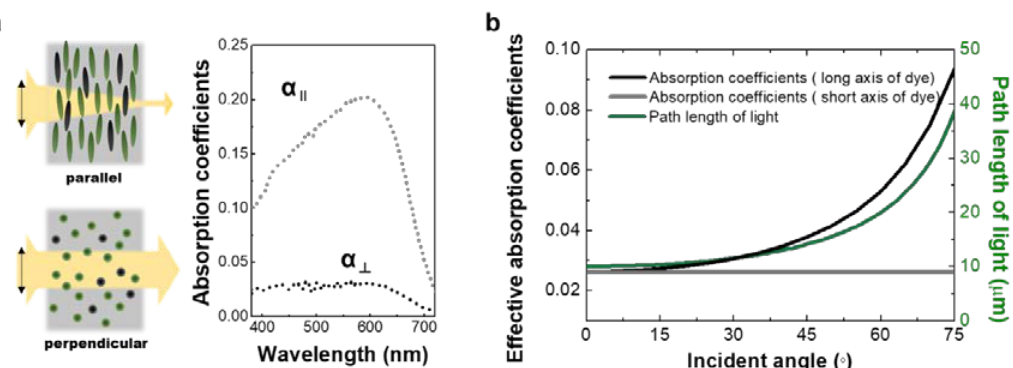
Figure 2. ( a ) Absorption coefficients of the black dichroic dye X12. ( b ) Calculated effective absorption coefficients and path length with increasing incident angle.